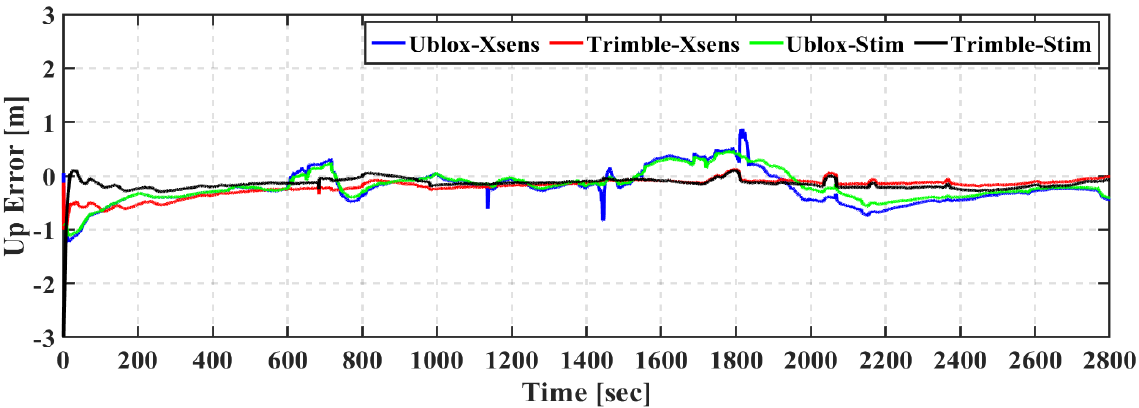
Figure 14. Second field trial: East positioning error of real-time TC GNSS PPP/INS for Ublox–Xsens, Trimble–Xsens, Ublox–Stim, and Trimble–Stim solutions.